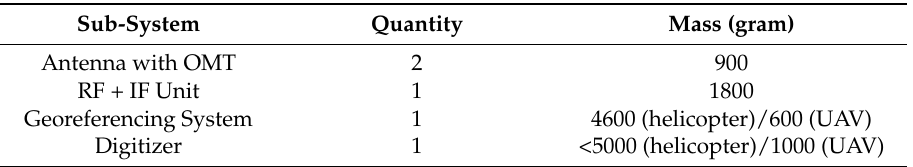
Table 3. Mass of the Tomoradar